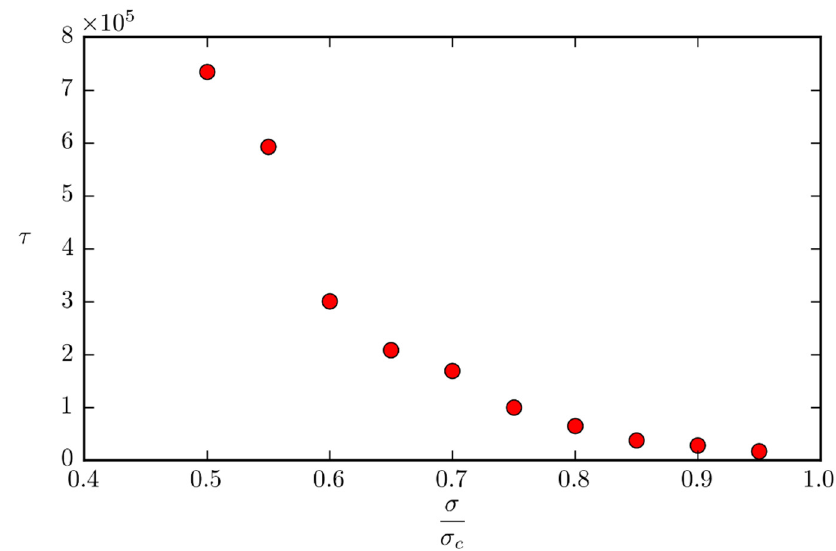
Figure 7. Dependence of the time for a protrusion to form with the force.